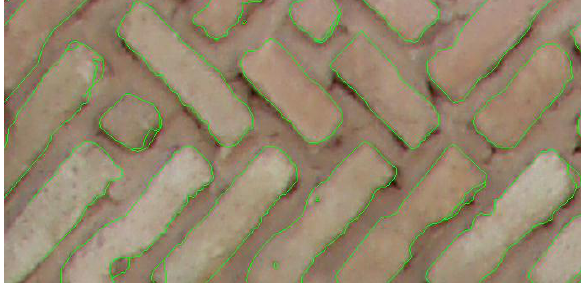
Figure 11. A part of the Brick work decoration of façade, CAD